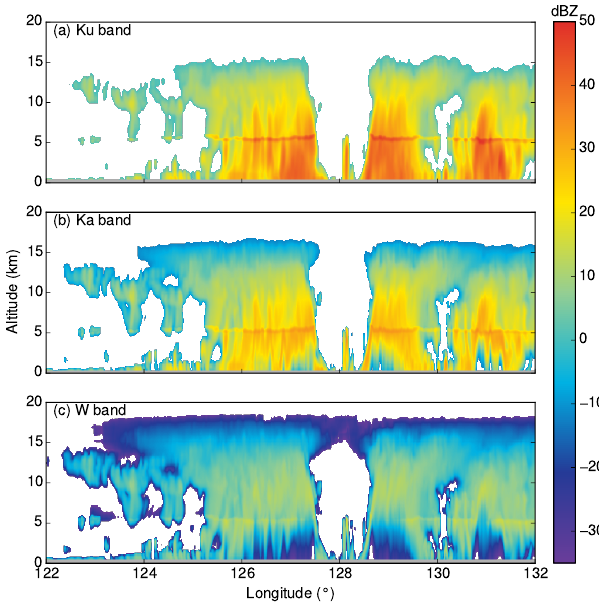
Figure 1. Example vertical cross sections of radar reflectivity from the CYC case described in Sect. 5.4. (a) Reflectivity at the Ku band; (b) at the Ka band; (c) at the W band. The gray area at the bottom of each cross section marks the area below 400m altitude, and thus contaminated by surface